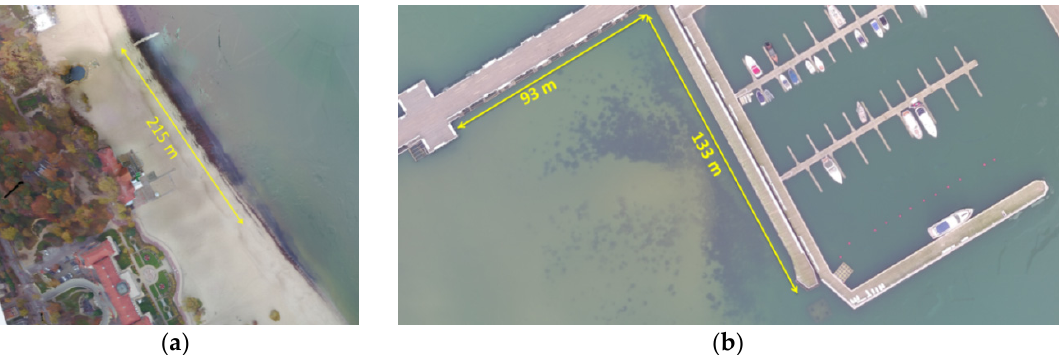
Figure 4. Water blooming in the vicinity of the Grand Hotel in Sopot ( a ) and the yacht marina in Sopot ( b ).